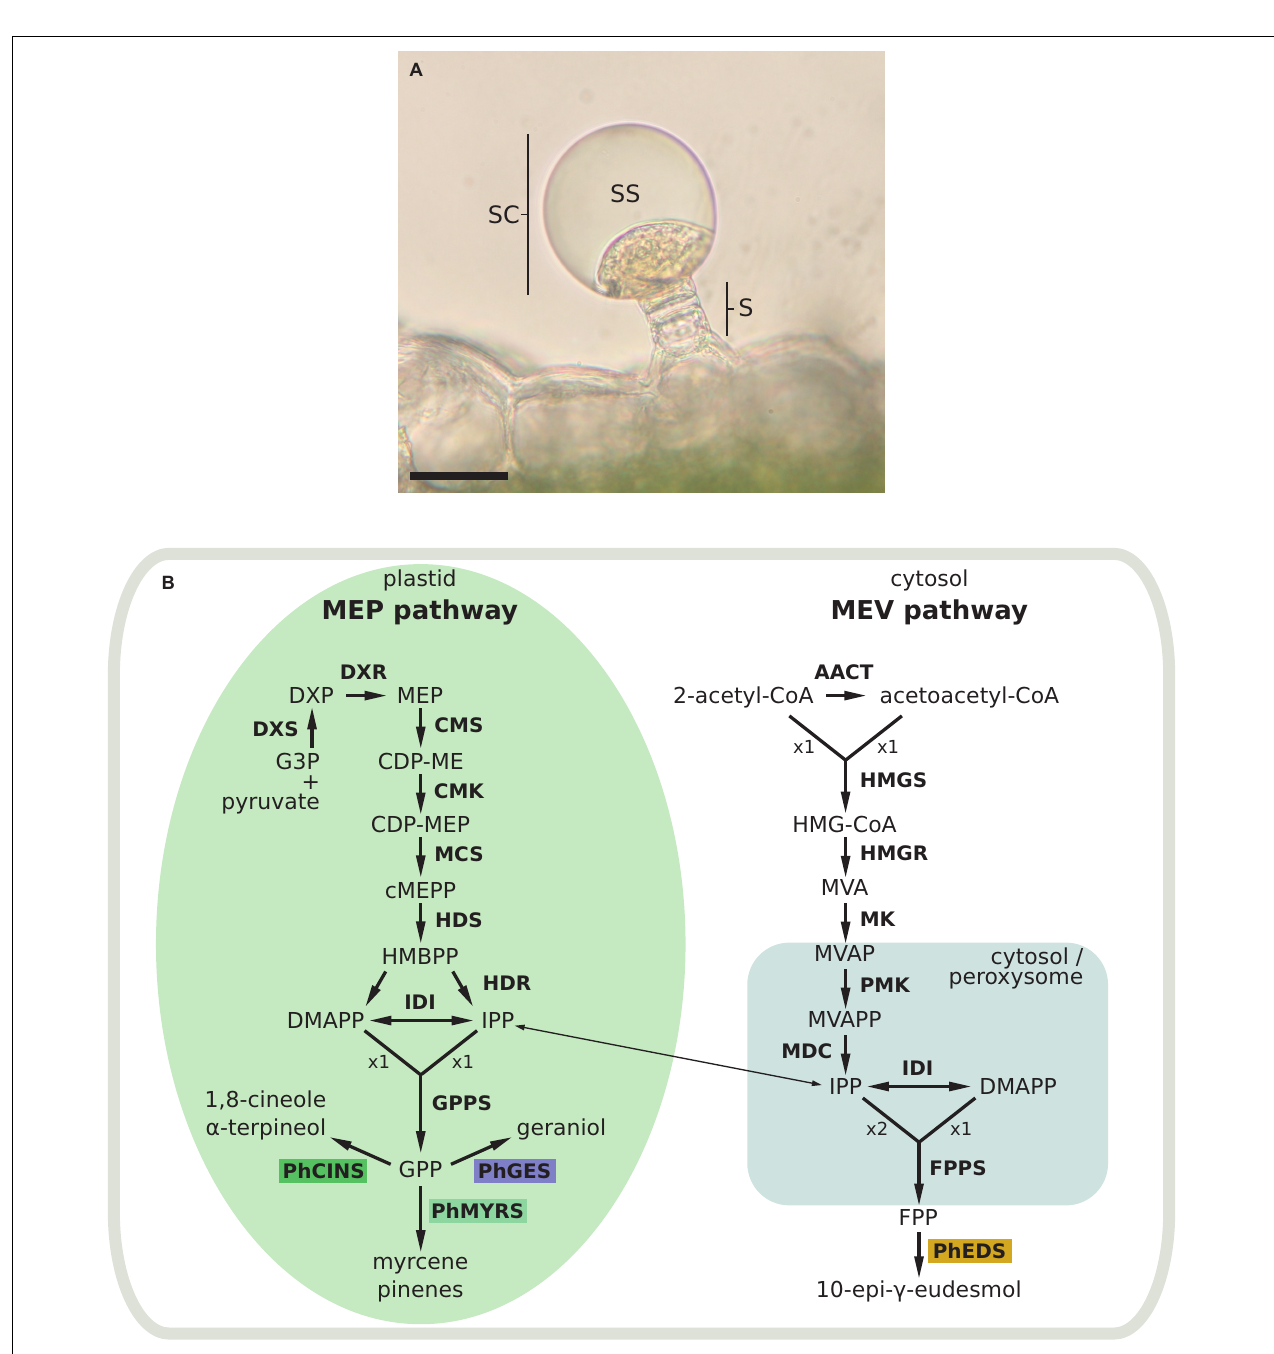
FIGURE 1 | Glandular trichome and mono and sesquiterpenes biosynthetic pathways in Pelargonium . (A) Capitate secretory gland with a stack (s) constituted of several cells and surrounded by a head secretory cell (sc). Terpenes accumulate in the subcuticular space (ss). Bar scale = 10 µ m. (B) Biosynthetic pathways of mono and sesquiterpenes. Enzymatic steps in the yellow box correspond to enzymes functionally characterised in this study. Enzymatic steps upstream of terpene biosynthesis are in bold letters. AACT, acetoacetyl-coenzyme A thiolyase; CDP-ME, 4-(cytidine 5 (cid:48) -diphospho)-2- C -methyl- D -erythritol; CDP-MEP, CDP-ME-2-phosphate; cMEPP, 2- C -methyl- D -erythritol 2,4-cyclodiphosphate; PhCINS, cineole synthase; CMK, 4-(cytidine 5 (cid:48) -diphospho) 2- C -methyl- D -erythritol kinase; CMS, 2- C -methyl- D -erythritol 4-phosphate transferase; DMAPP, dimethylallyl diphosphate; DXP, 1-deoxy- D -xylulose 5-phosphate; DXR, DXP reductoisomerase; DXS, DXP synthase; PhEDS, eudesmol synthase, FPP, farnesyl diphosphate; FPPS, FPP synthase; PhGES, geraniol synthase; G3P, glyceraldehyde 3-phosphate; GPP, geranyl diphosphate; GPPS, GPP synthase; HDS, 1-hydroxy-2-methyl-2( E )-butenyl 4-diphosphate synthase; HDR, 1-hydroxy-2-methyl-2( E )-butenyl 4-diphosphate reductase; HMBPP, 1-hydroxy-2-methyl-2( E )-butenyl 4-diphosphate; HMGCoA, 3-hydroxy-3-methylglutaryl-CoA; HMGR, hydroxymethylglutaryl-CoA reductase; HMGS, hydroxymethylglutaryl-CoA synthase; IDI, isopentenyl diphosphate isomerase; IPP, isopentenyl diphosphate; MDC, mevalonate pyrophosphate decarboxylase; MCS, 2- C -methyl- D -erythritol 2,4-cyclodiphosphate synthase; MEP, 2- C -methyl- D -erythritol 4 phosphate; MK, mevalonate kinase; MVA, mevalonate; MVAP, MVA-5-phosphate; MVAPP, MVA-5-diphosphate; PhMYRS, myrcene synthase; PMK, 5-phosphomevalonate kinase.